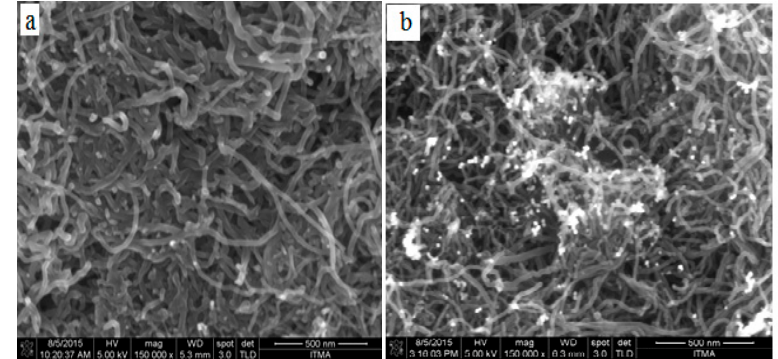
Figure 2. FESEM Images of ( a ) MWCNTs film; and ( b ) AuNPs/en-MWCNTs films.